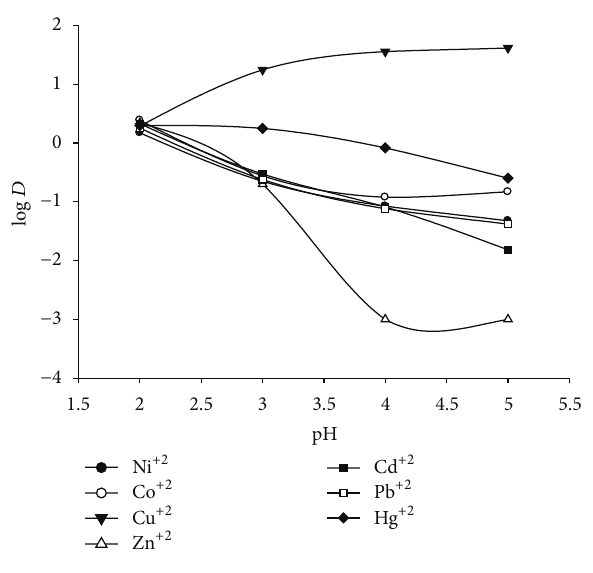
Figure 3: pH-log 𝐷 graph of L2 ligand.